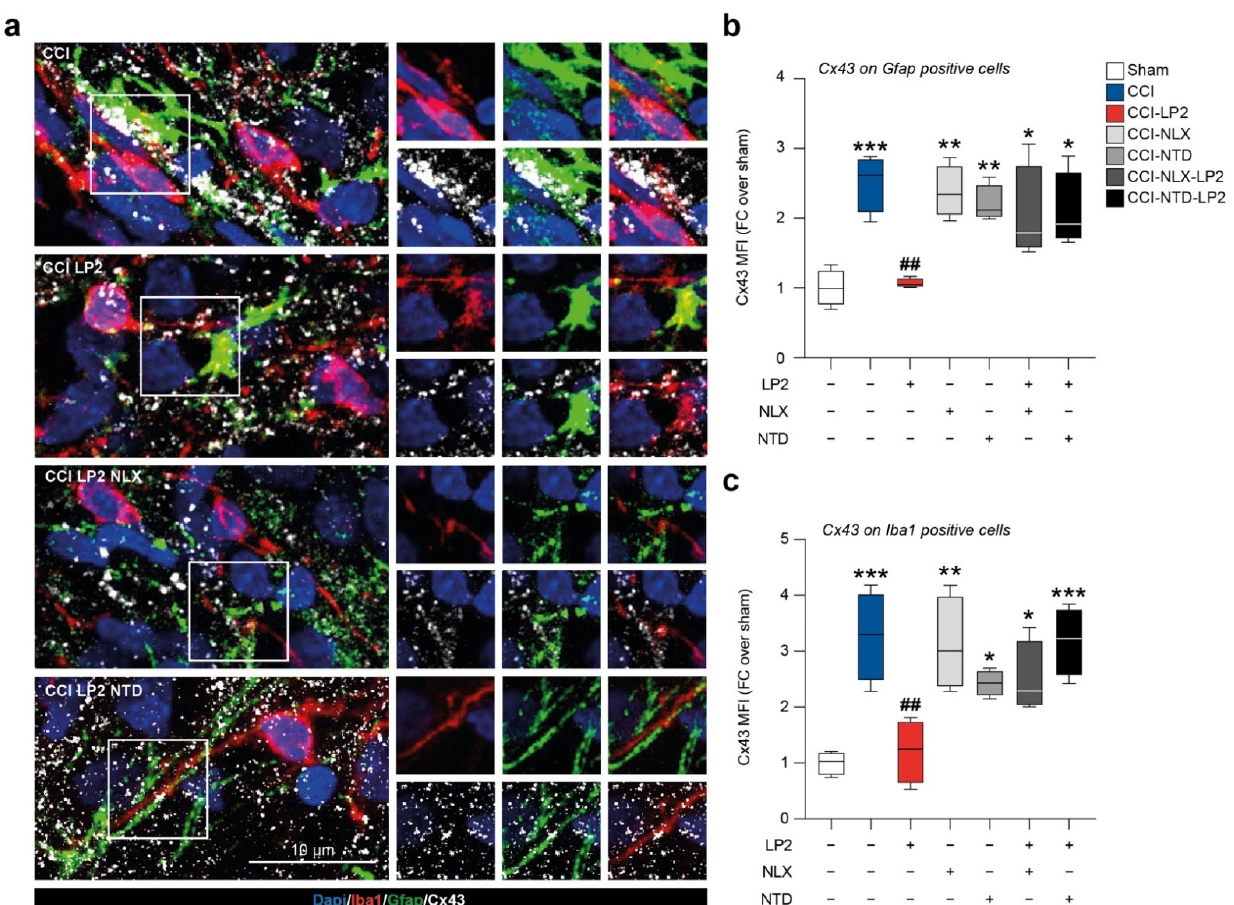
Figure 5. Iba1, Gfap, and Cx43 immunofluorescence analysis on spinal cord sections. ( a ) Representative confocal-assisted immunofluorescence pictures of CCI-, CCI-LP2-, CCI-NLX-LP2-, and CCI-NTD-LP2-treated rats. ( b , c ) Quantification of Cx43 MFI over ( b ) Gfap- and ( c ) Iba1-positive cells. CCI, chronic constriction injury; MOR, mu opioid receptor; DOR, delta opioid receptor; NLX, naloxonazine; NTD, naltrindole; FC, fold change; MFI, mean fluorescence intensity. * p -value < 0.05, ** p -value < 0.01, and *** p -value < 0.001 versus sham and ## p -value < 0.01 versus CCI.